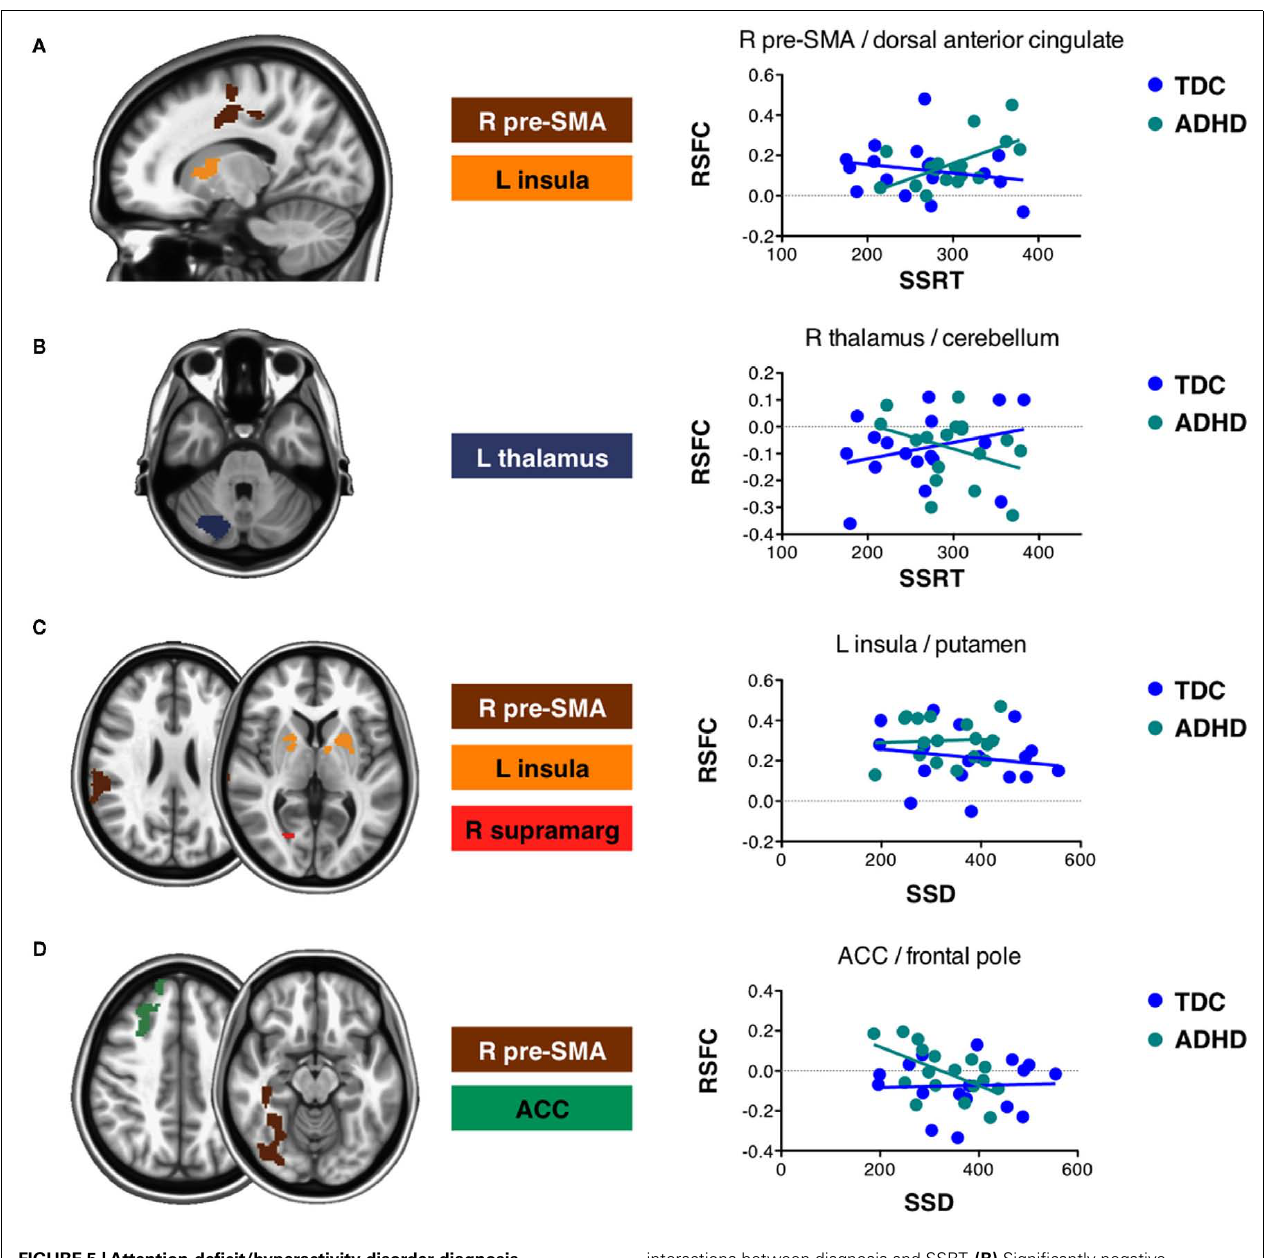
FIGURE 5 |Attention-deficit/hyperactivity disorder diagnosis modulated connectivity–behavior relationships for SSRT and SSD. Slices display regions exhibiting a significant effect of diagnosis on their connectivity–behavior relationship ( Z > 2.3; p < 0.05, corrected for multiple comparisons). Interactions were observed for both SSRT and SSD obtained during the stop signal task. Graphs illustrate example interactions. (A) Significantly positive